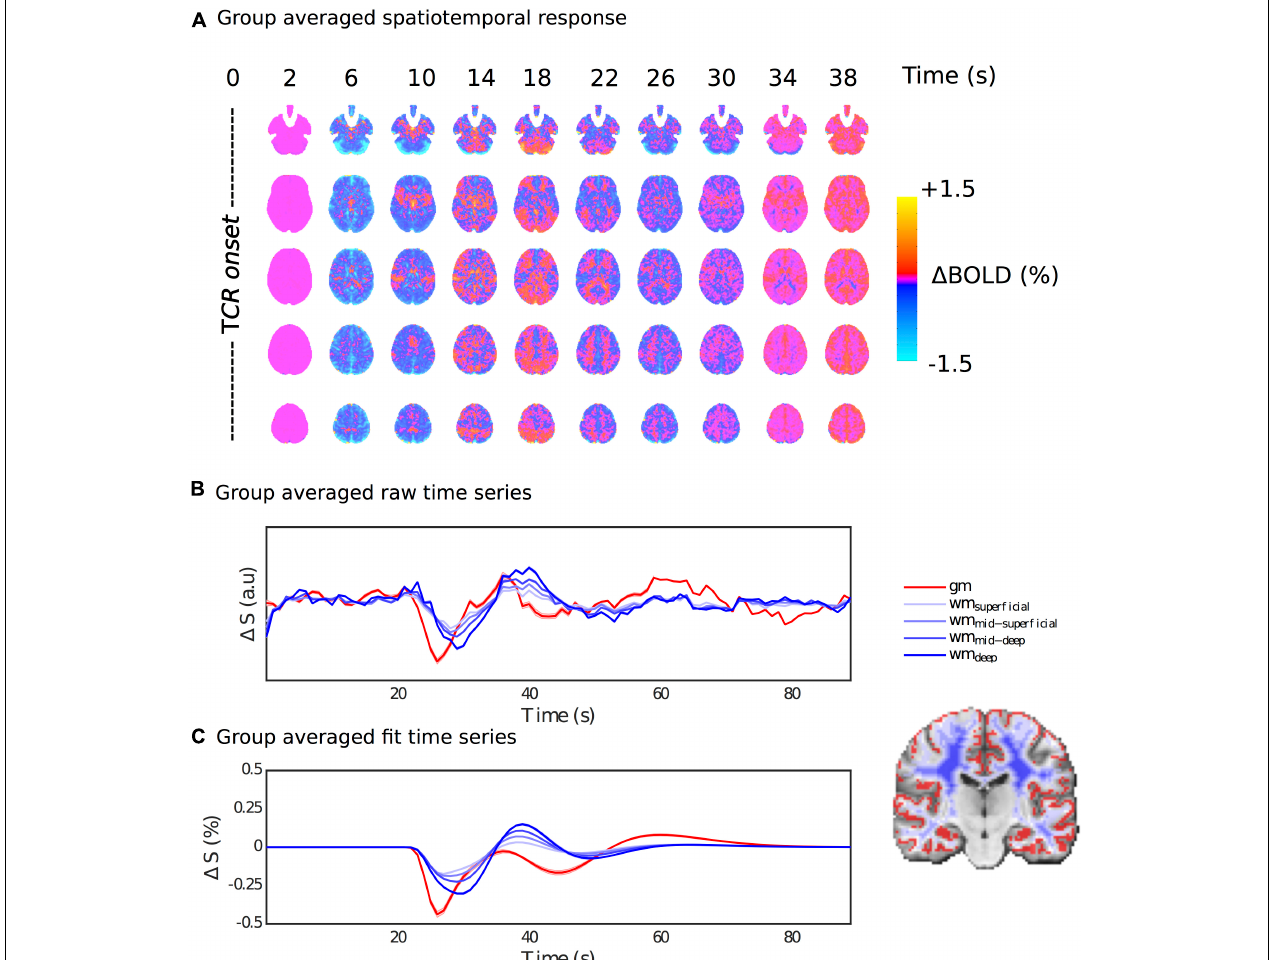
FIGURE 4 | Spatiotemporal dynamics of the HRF TCR . (A) Percentage BOLD signal changes at multiple time points post TCR onset are shown in order to visualize the spatiotemporal variability of the HRF TCR . (B,C) Show raw and fitted responses, respectively, different tissue masks.